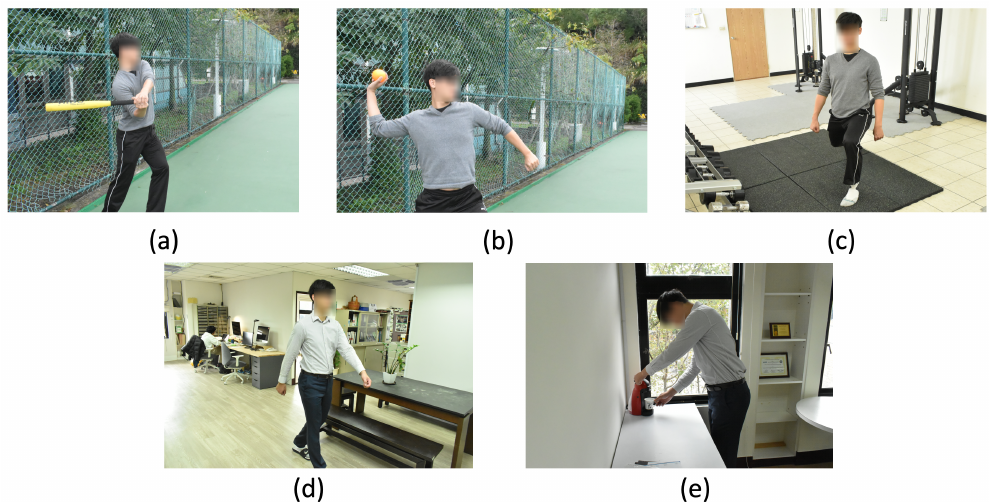
Figure 1. The proposed baseball player behavior classification system: ( a ) the swing behavior of a baseball player, ( b ) the pitch behavior of a baseball player, ( c ) a warm-up exercise, ( d ) the normal walking of a baseball player outside the sport, and ( e ) coffee-pouring behavior in daily life, outside the